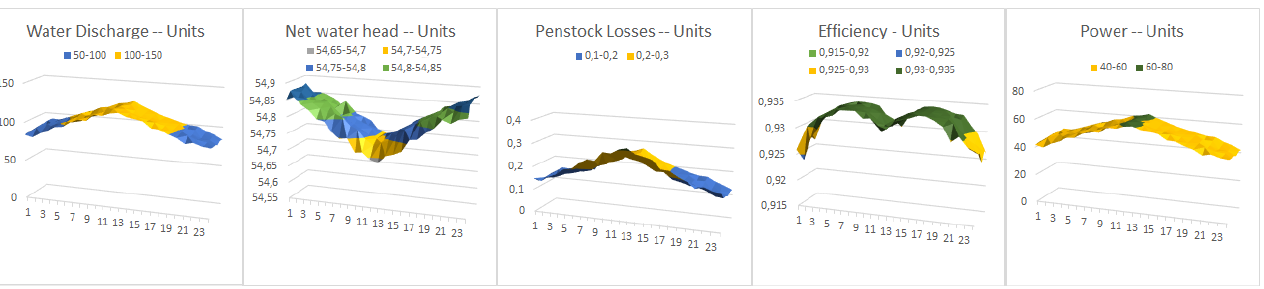
Figure 8. Differential Evolution (rand/1/bin)—DER. Results of Water discharge (m 3 /s). Net water head (m). Penstock (m). Efficiency (%) and Power generated (MW/h). Daily dispatch (24 h).